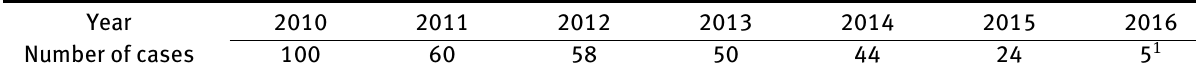
Table 1: Development of fraudulent transports between 2010 and